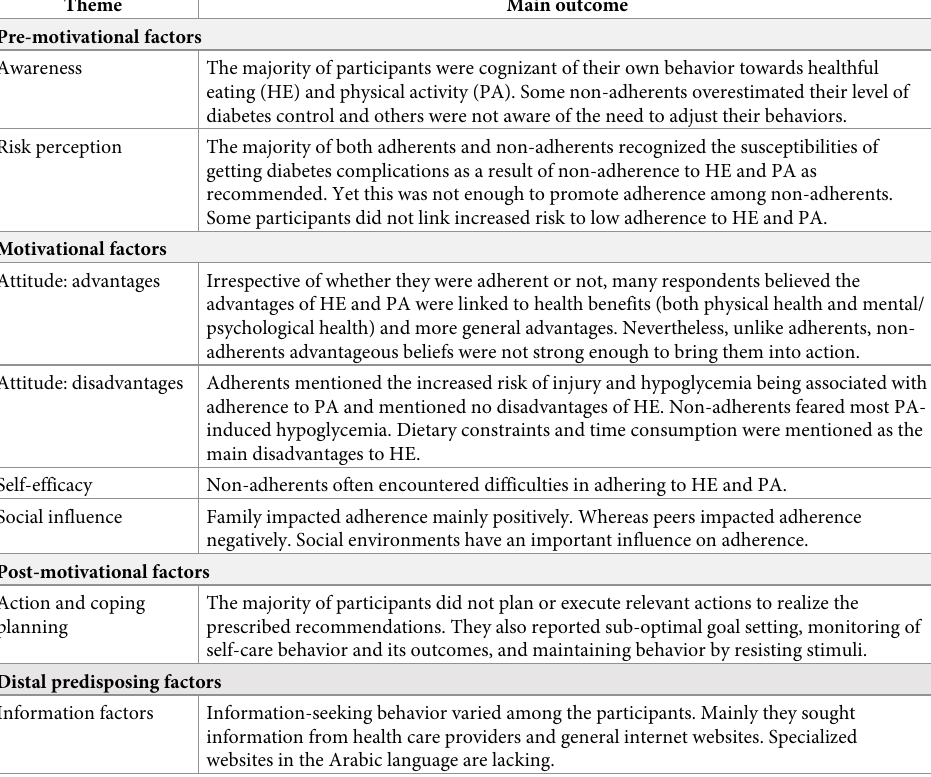
Table 6. Summary of